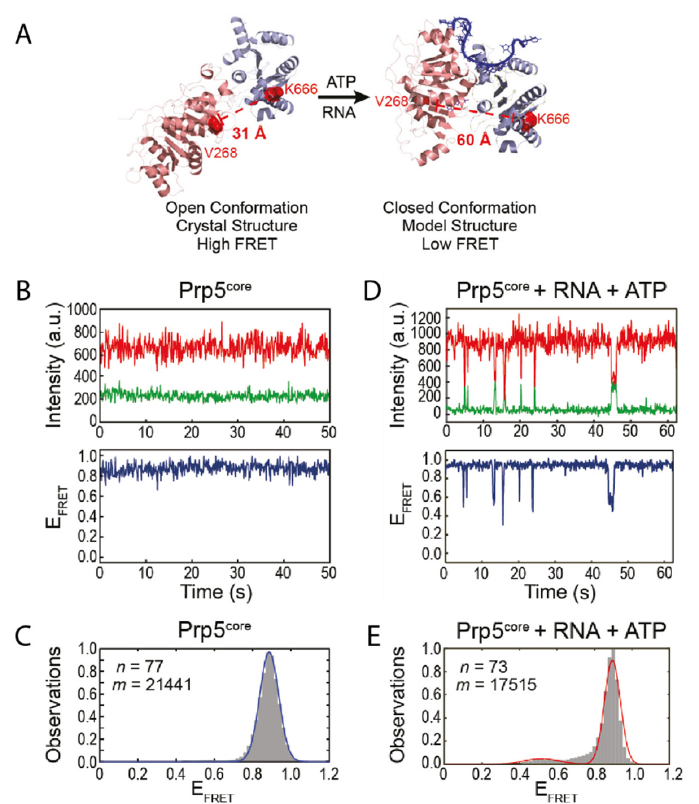
Figure 1. Conformational changes within Prp5. ( A ) Crystal structure of Prp5 in the twisted open conformation and modelled structure of closed conformation. The two RecA-like domains of Prp5 are shown in pink and purple and the RNA in the closed conformation in blue. The residues mutated for fluorophore introduction are indicated in red. ( B ) Exemplary Förster resonance energy transfer (FRET) trajectory of Prp5 alone and ( C ) the corresponding FRET histogram fitted with one peak (blue line). ( D ) FRET behavior of Prp5 in the presence of poly (A) RNA and ATP and ( E ) the corresponding FRET histogram fitted with two peaks (red line). This Figure was taken from Beier et al. [18] and is used under Creative Commons Non-Commercial License (CC-BY NC).